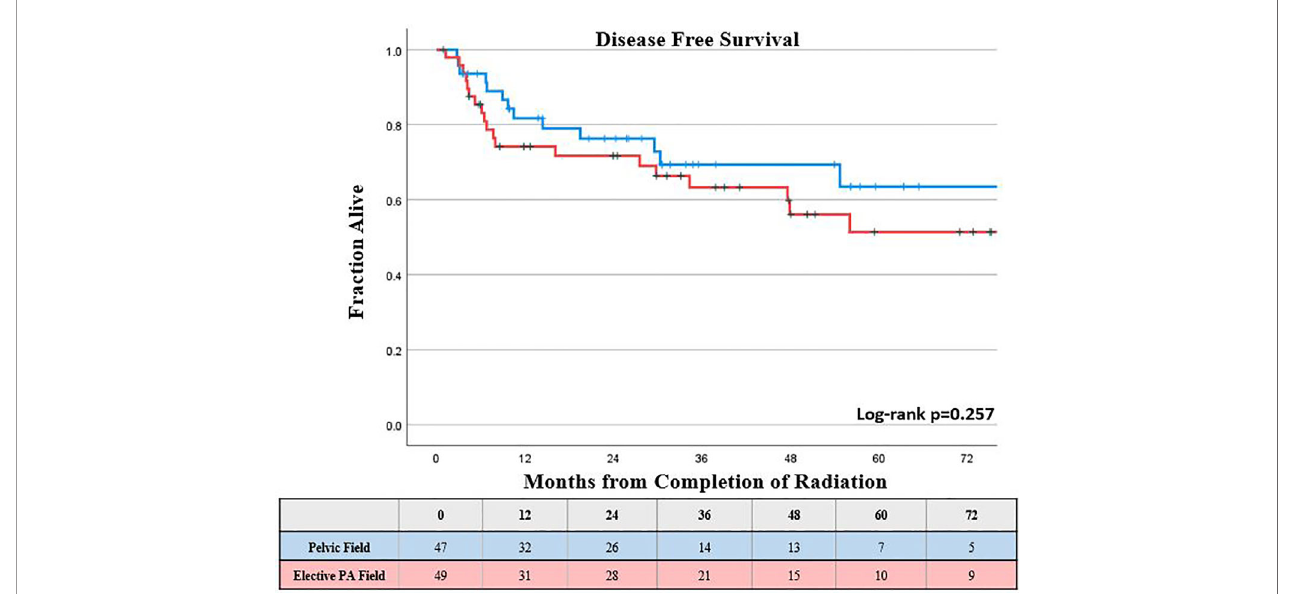
FIGURE 3 | Kaplan-Meier estimated disease free survival by type of treatment fi